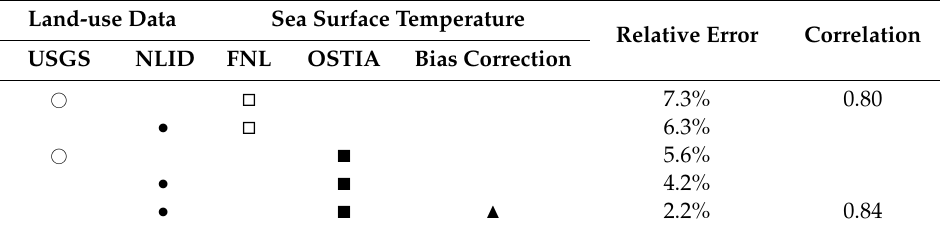
Table 7. Relative error for each case.